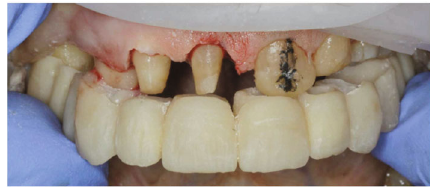
Figure 7: The abutment teeth were adapted to the interim restoration used as a guide for the dental